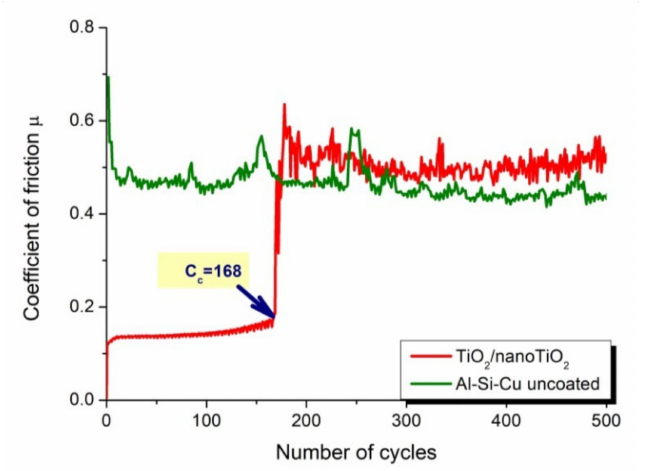
Figure 11. Friction coefficient as a function of the number of cycles for the uncoated Al-Si-Cu alloy substrate material and the TiO 2 /nanoTiO 2 coating obtained by a hybrid